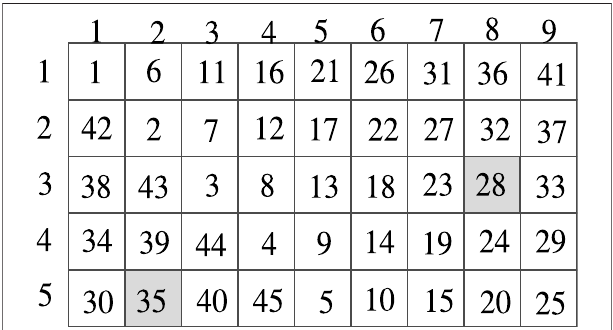
FIGURE1| Thisisapictureoftheorder O 5×9 onthecoordinateset C 5×9 . For examples, O 5×9 [( 3 , 8 )] (cid:3) ( 8 − 3 ) × 5 + 3 (cid:3) 28, and O 5×9 [( 5 , 2 )] (cid:3) ( 9 , + , 2 − 5 ) × 5 + 5 (cid:3)